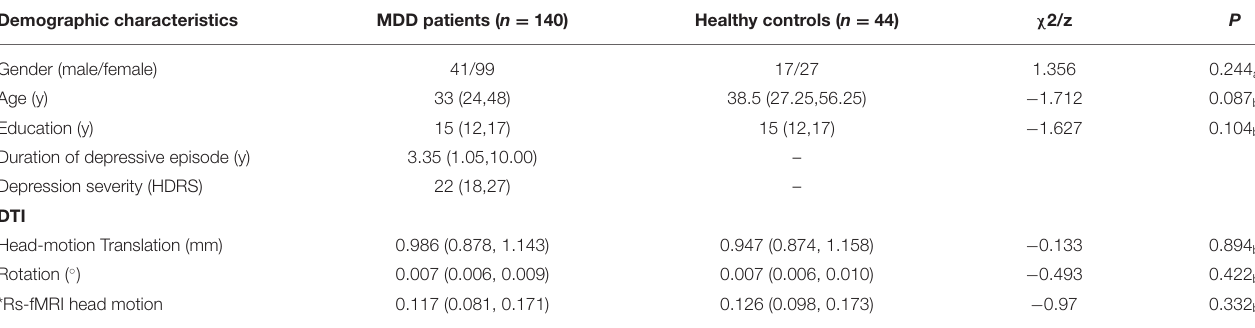
TABLE 1 | Demographic and clinical characteristics of patients with recurrent major depressive disorder (MDD) and healthy controls. Demographic